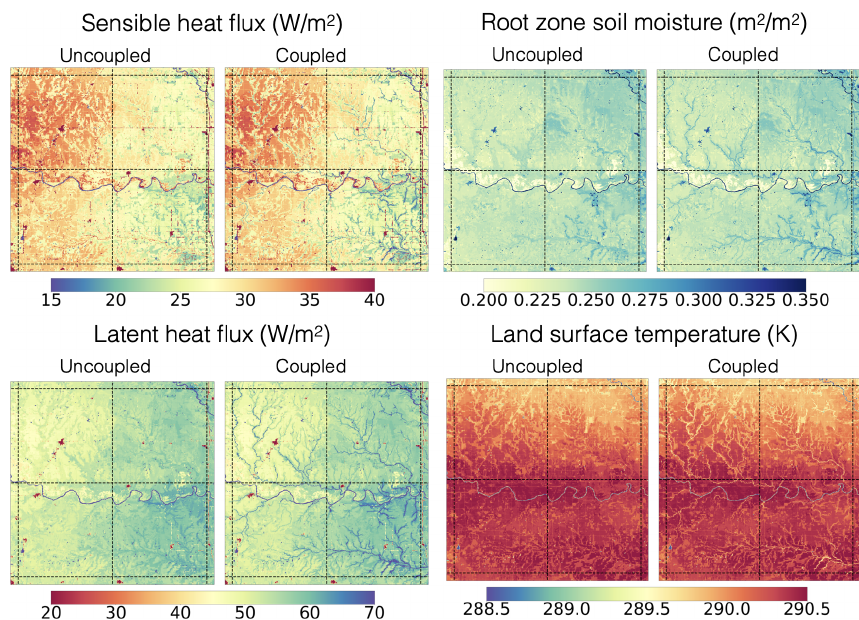
Figure 7. Annual mean sensible heat flux, latent heat flux, root zone soil moisture, and land surface temperature. The left column shows the results for the uncoupled simulations (i.e., the routing scheme does not interact with the land surface), while the right column shows the coupled simulations. Data were upscaled to a 100m resolution for